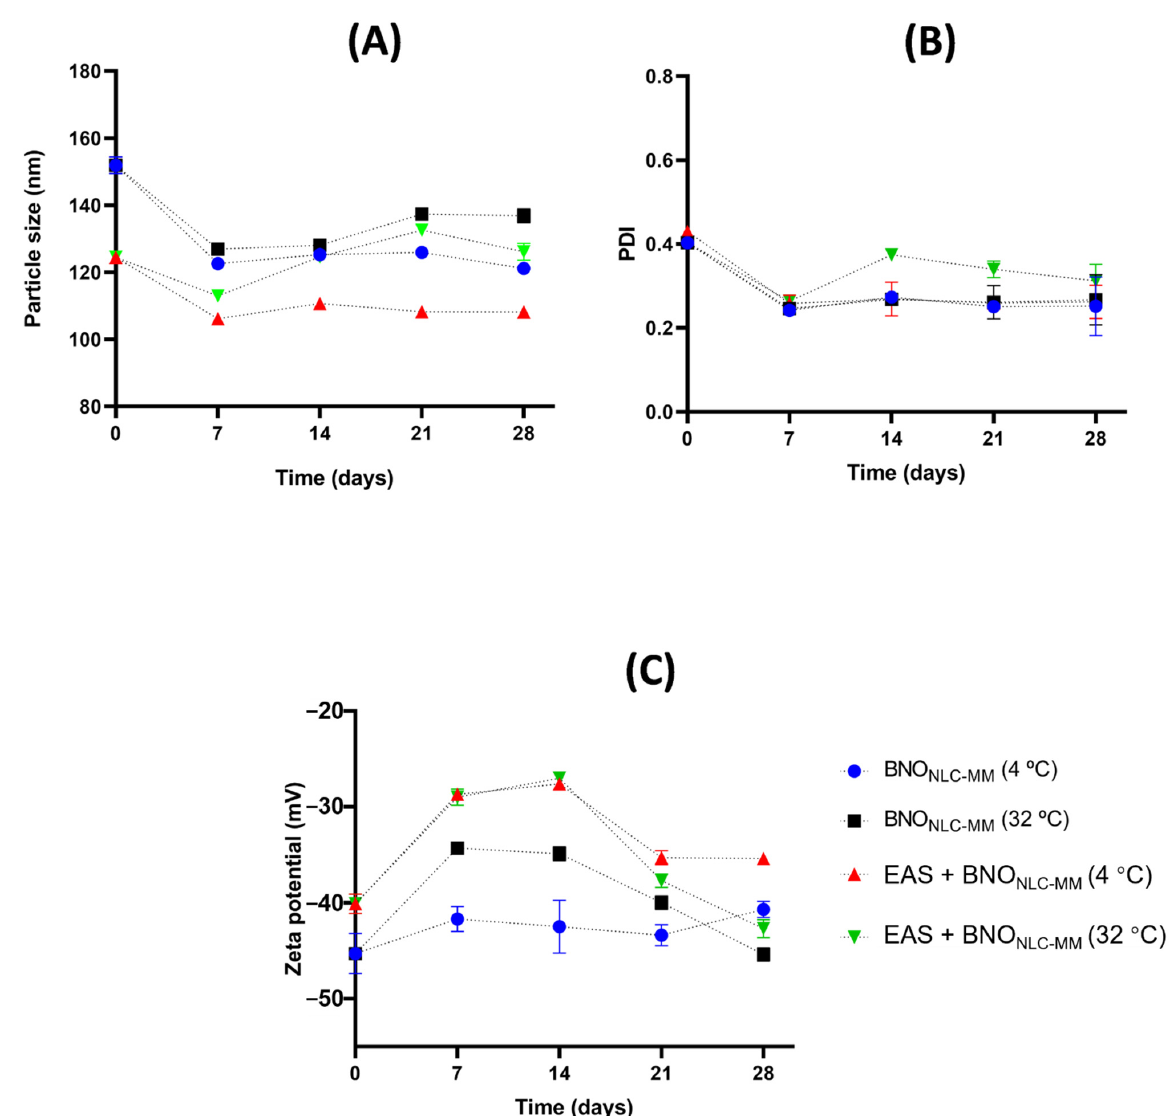
Figure 5. Particle size of SO NLC and ASE + SO NLC ( A ); PDI ( B ) and Zeta potential ( C ) of BNO NLC and ASE + BNO NLC stored at temperatures of 4 °C and 32 °C.